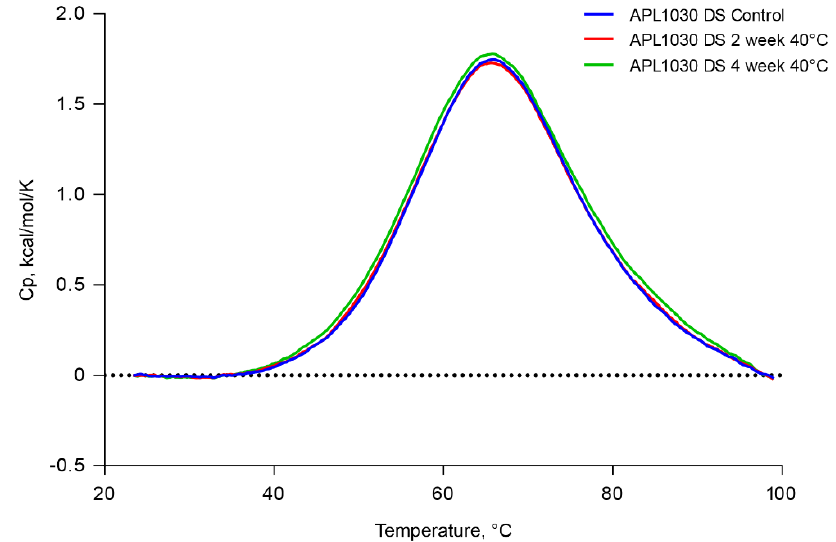
Figure 7. APL-1030 is stable for 1 month at 40 °C. Thermal stability of APL-1030 was assessed by differential scanning calorimetry at time 0, 2, and 4 weeks of constant exposure to 40 °C temperature. Cp, specific heat capacity; DS, differential scanning. N = 1 sample per test condition.